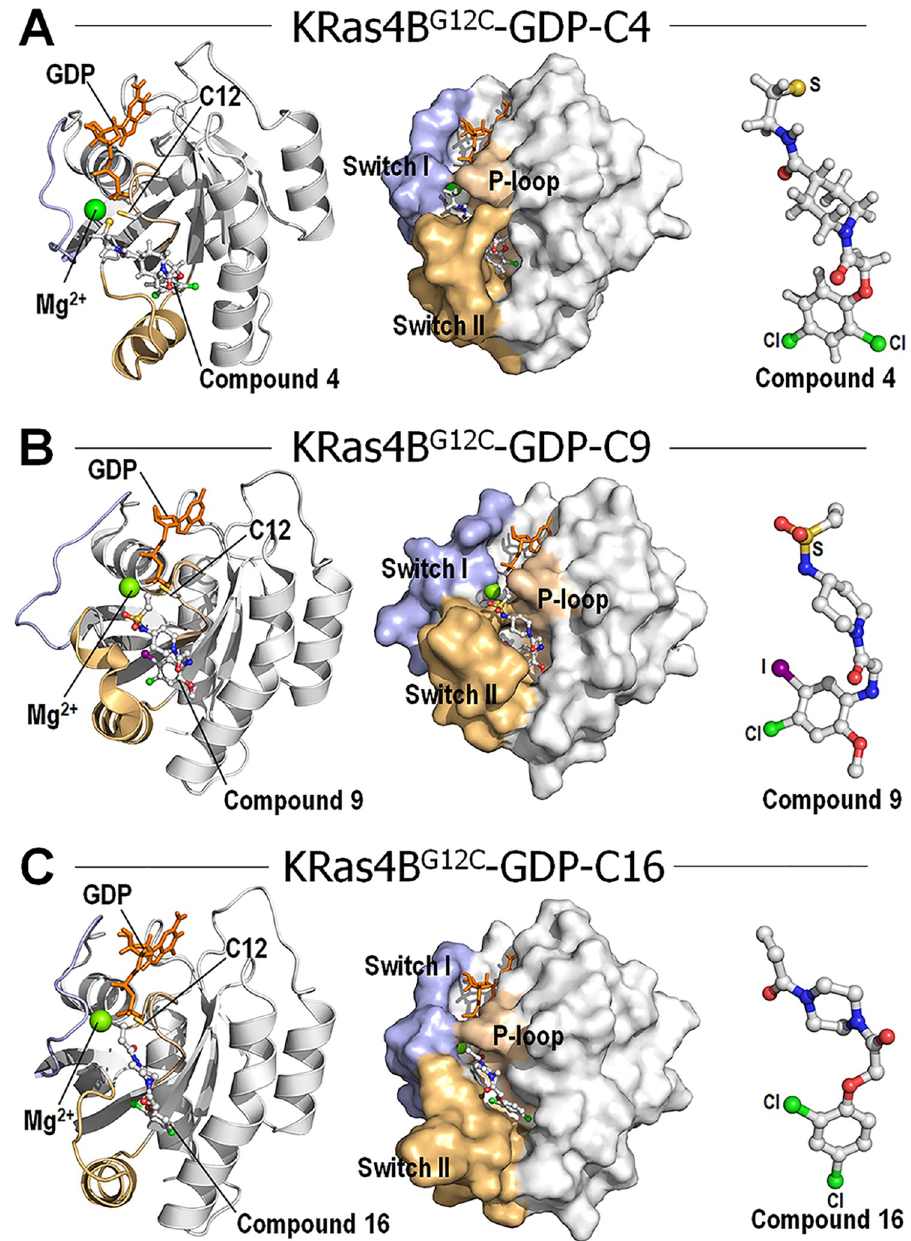
Fig 11. Crystal structures of KRas4B G12C and covalent inhibitors. Cartoon (left panel) and surface (middle panel) representations of the crystal structure of KRas4B G12C -GDP in complex with covalently linked inhibitors (right panel) of (A) compound 4, (B) compound 9, and (C) compound 16 (PDB codes: 4LV6, 4LYJ, and 4M22, respectively) [116]. In the protein structures, light green, blue, and orange colors denote the P-loop, Switch I, and Switch II regions, respectively. In the compound structures, C, N, and O atoms are denoted as white, blue, and red spheres, respectively. Hydrogen atom is represented as an edge of stick. Other heavy atoms, S, Cl, and I atoms are marked on the sphere.